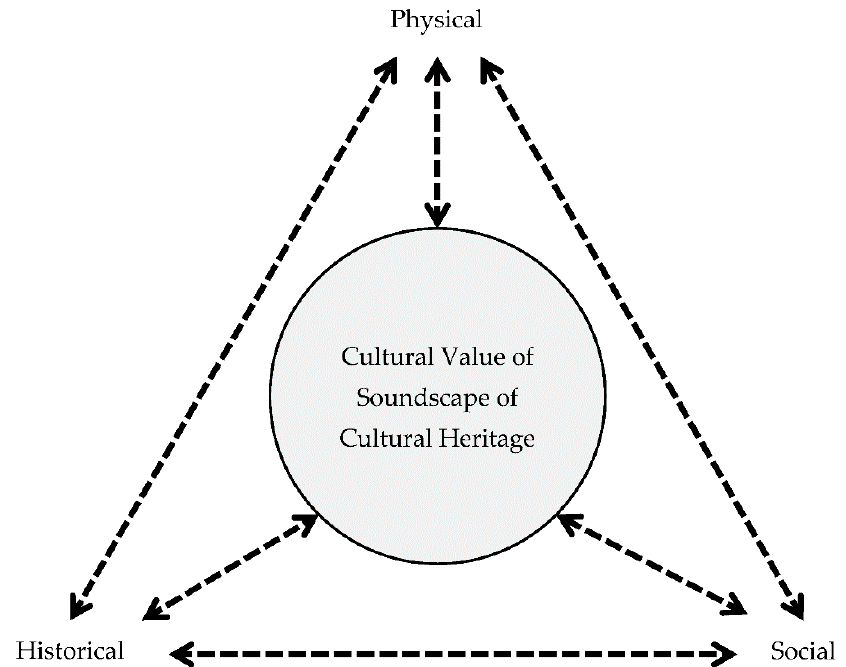
Figure 1. The Methodological Triangulation. Source: Redrawn after Maffei (2016).